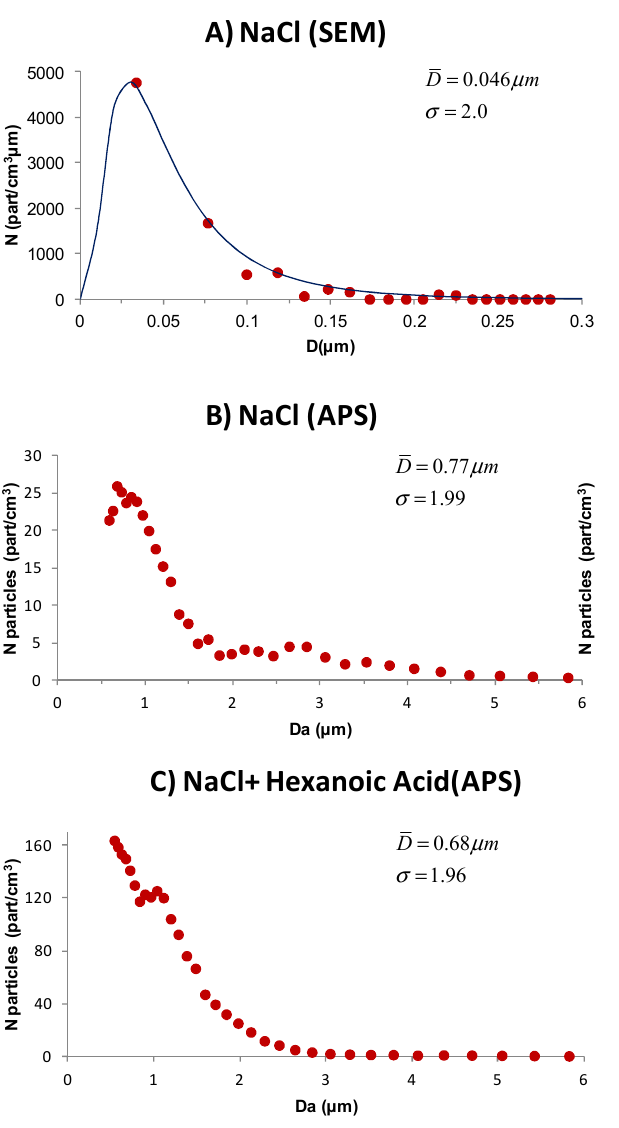
Figure 2. Representative particle size distributions of dry NaCl aerosol. Panel (a) has been obtained by imaging particles deposited on a glass slide by SEM technique and counting them with the ImageJ software [http://rsbweb.nih.gov/ij/docs/intro.html]. Panels (b) and (c) have been obtained by sizing particles by an aerody- namic particle spectrometer; pure NaCl particles (b) and heteroge- neously nucleated particles with hexanoic particles (c) are shown. coincident with the gas phase spectrum. A weak band located at near 1730 cm − 1 has been assigned to the C = O stretch originating from small particles of liquid HA due to homoge-